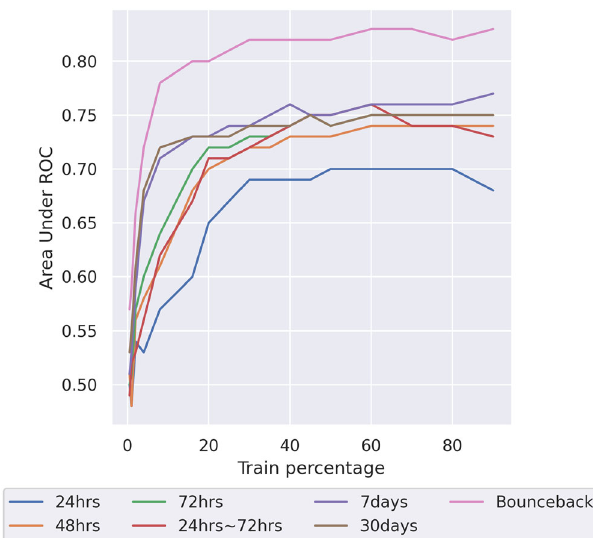
Fig. 3 Readmission prediction model performance as available data size varies. Area under receiver operator curve (AUROC) of model performance against dataset size for the readmission prediction models. The models show are readmission after 24 h (blue line), 48 h (orange line), 72 h (green line), from 24 to 72 h (red line), after 7 days (purple line), 30 days (brown line) and bounceback (pink line). Source data is in Supplementary Data